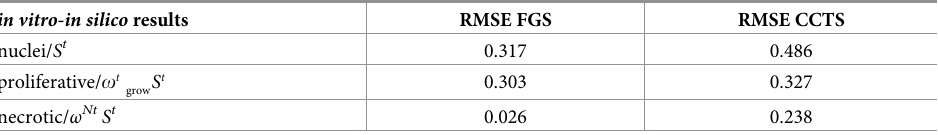
Table 2. Quantitative comparison between in vitro-in silico results, for the control groups FGS and CCTS. in vitro-in silico results